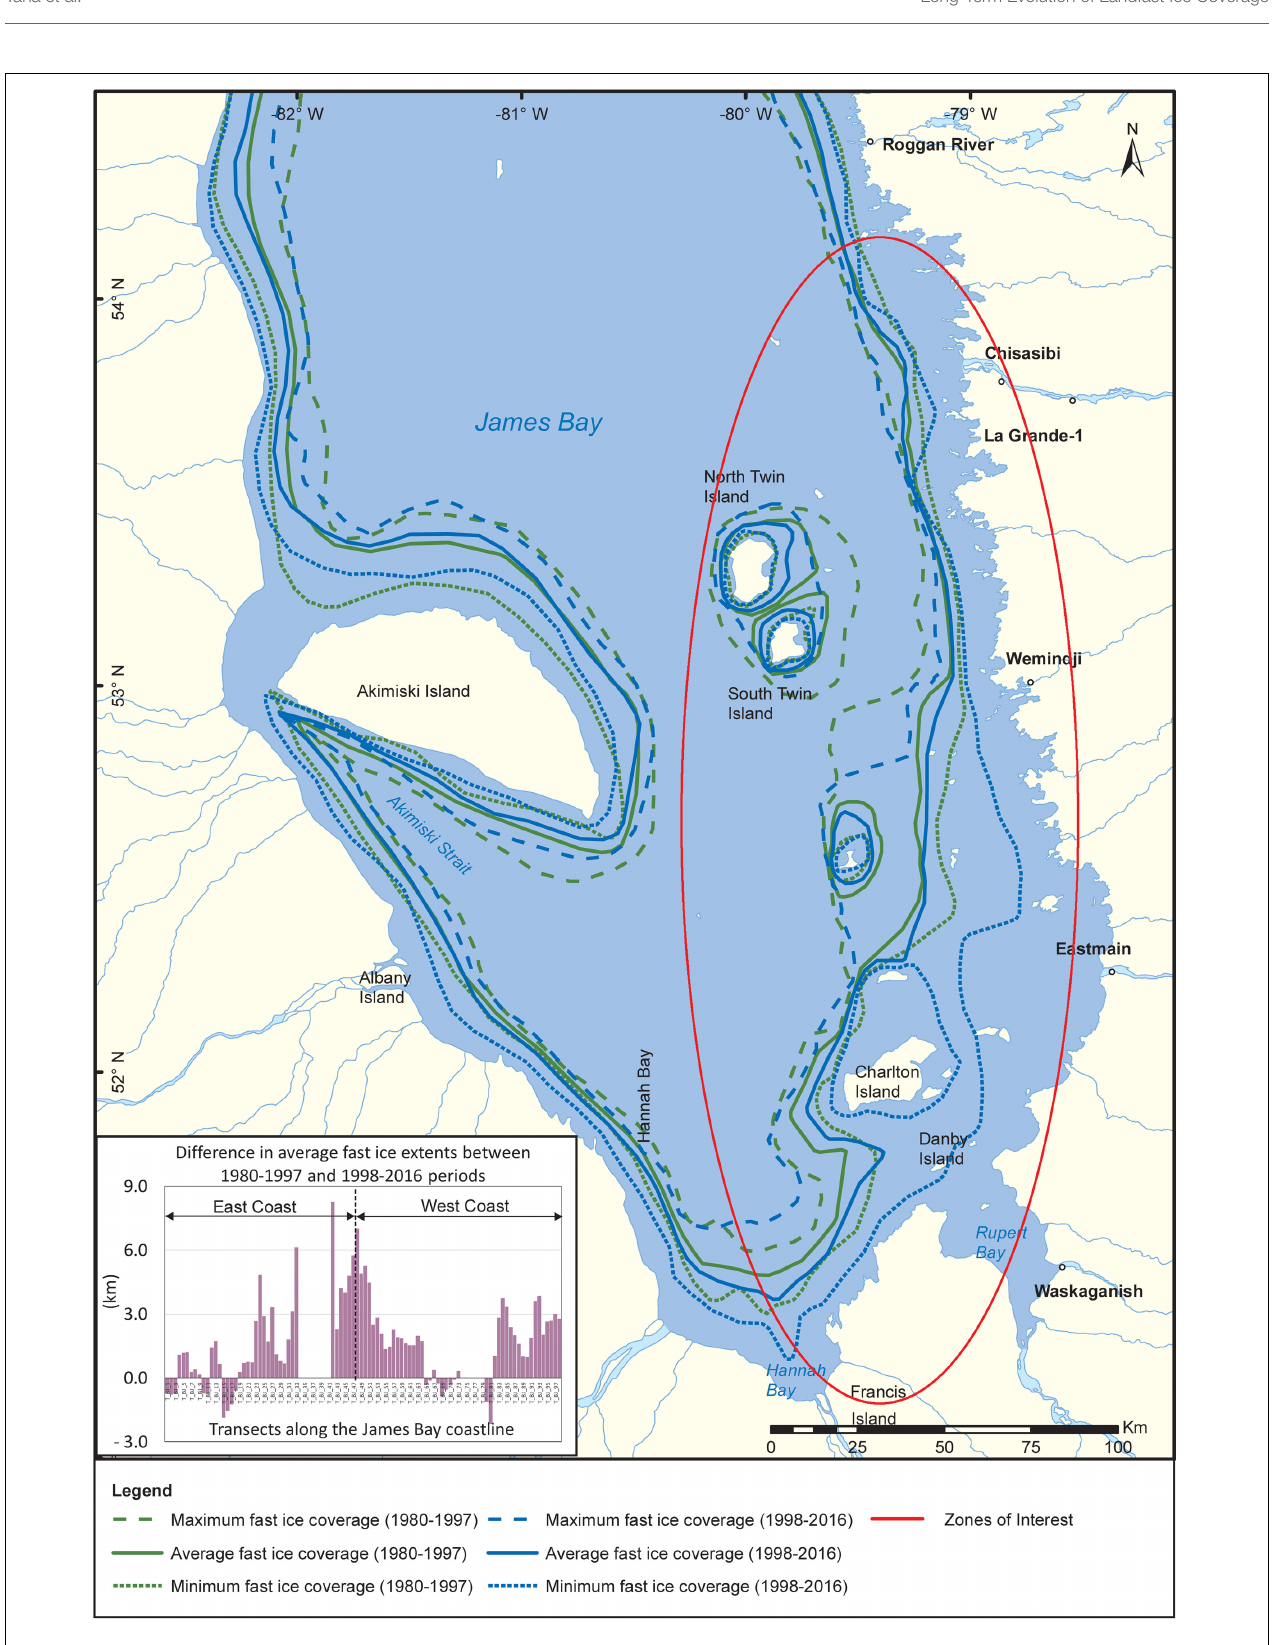
FIGURE 9 | Comparison of the landfast ice extent in James Bay for 1980–1997 (green lines) and 1998–2016 (blue lines) periods adapted from Taha et al. (2017).